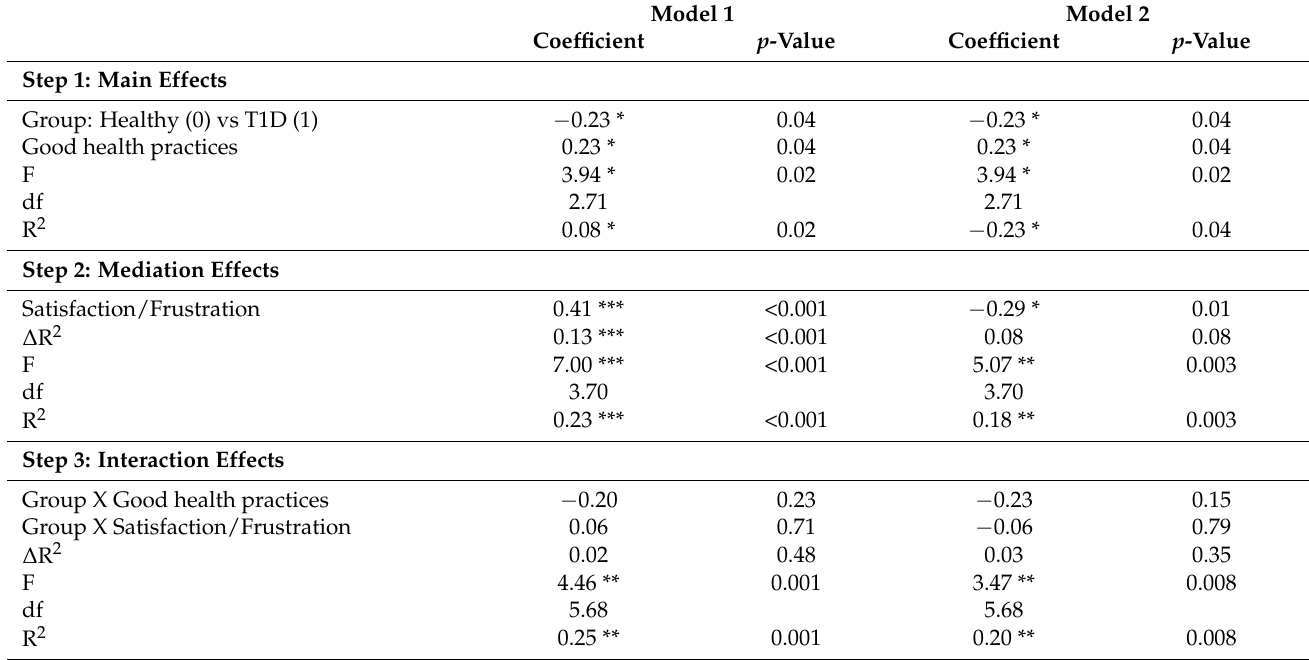
Table 6. Hierarchical regression models for the dependent variable physical well-being